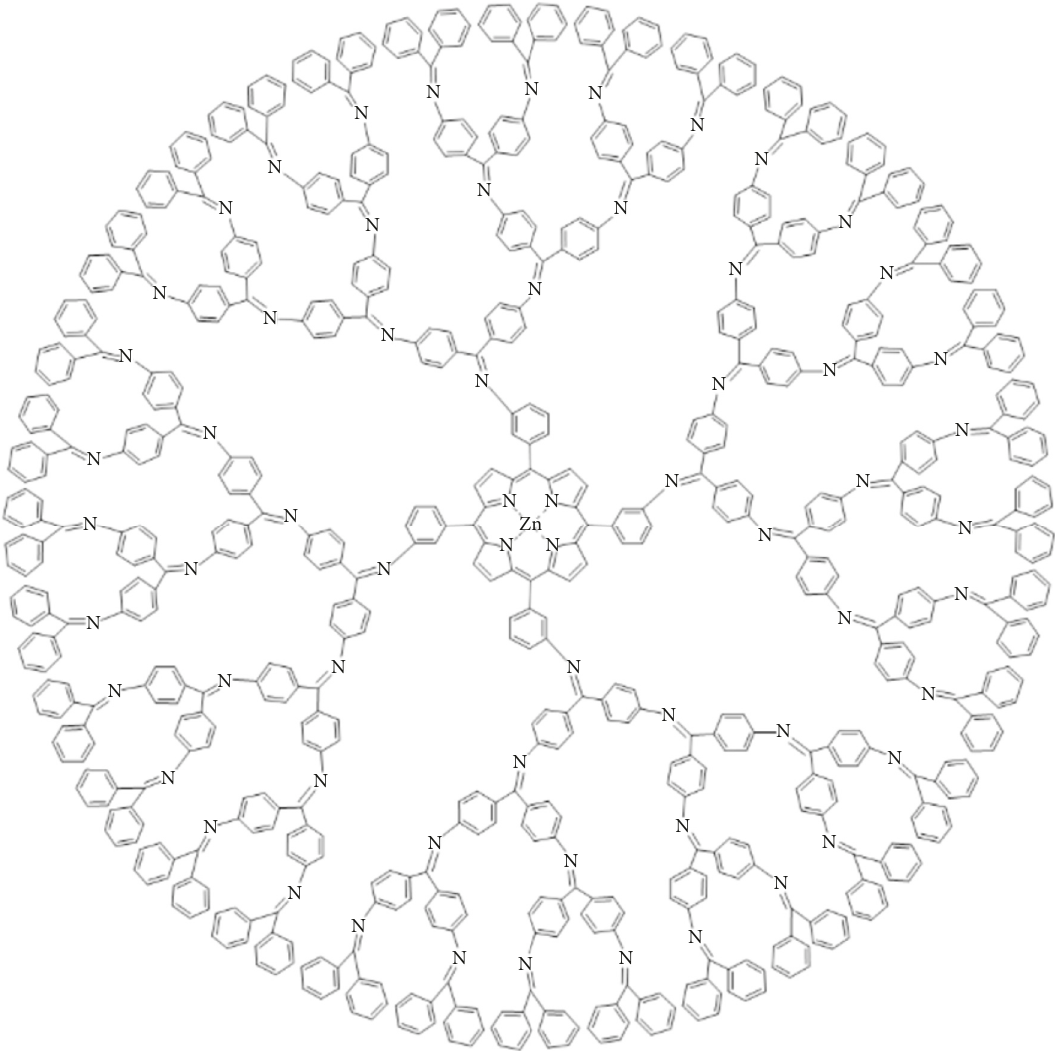
Figure 3: Zinc-Porphyrin